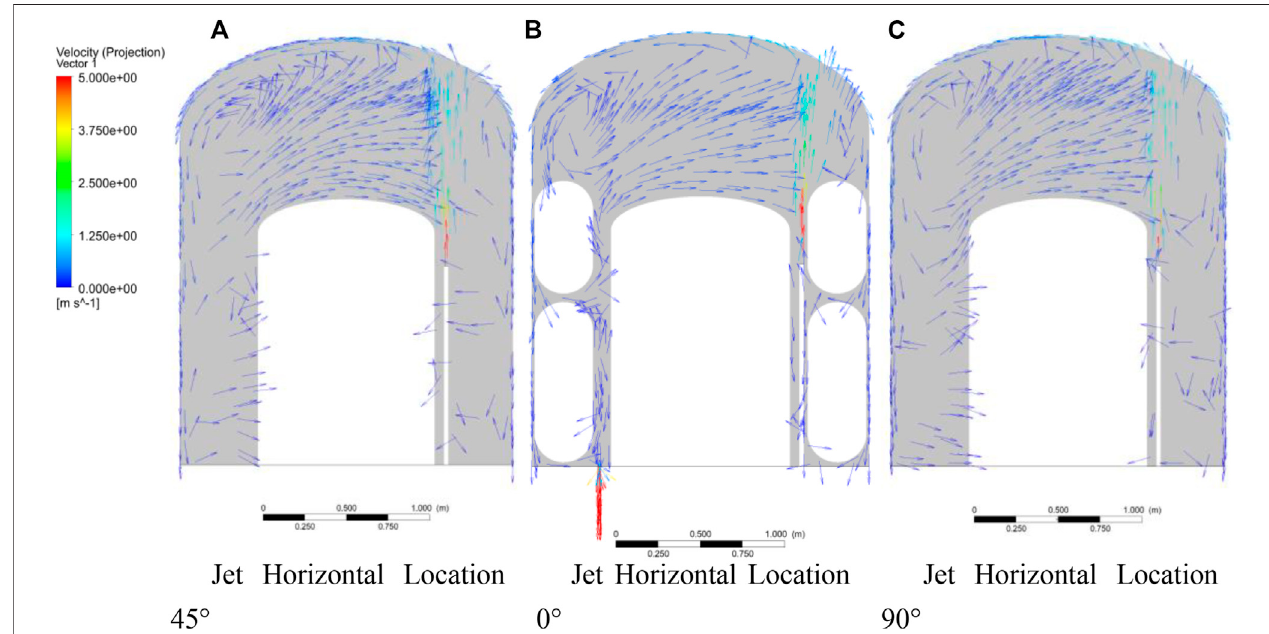
FIGURE 11 | Distribution of velocity vectors in the containment at different jet diameters. (A) Jet horizontal location 45 ° . (B) Jet horizontal location 0 ° . (C) Jet horizontal location 90 ° .